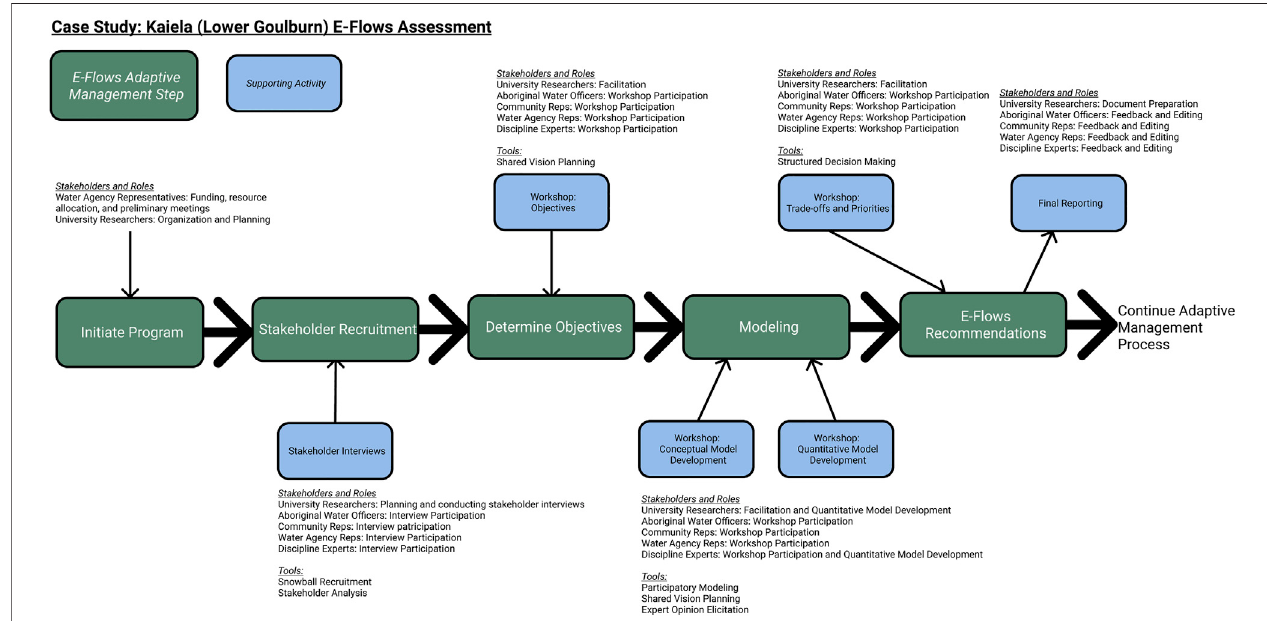
FIGURE 2 | Diagram showing the planning phase of an adaptive management cycle for e- fl ows management. The case presented here is an e- fl ows assessment for the Kaiela (Lower Goulburn) River in Northern Victoria, Australia. The boxes in green show the e- fl ows activities while the boxes in blue show the associated activities for these steps. The stakeholder roles and tools used are explained for each of these activities. While this process focused on the planning phase through an e- fl ows assessment, adaptive management is expected to continue through to doing and learning phases.